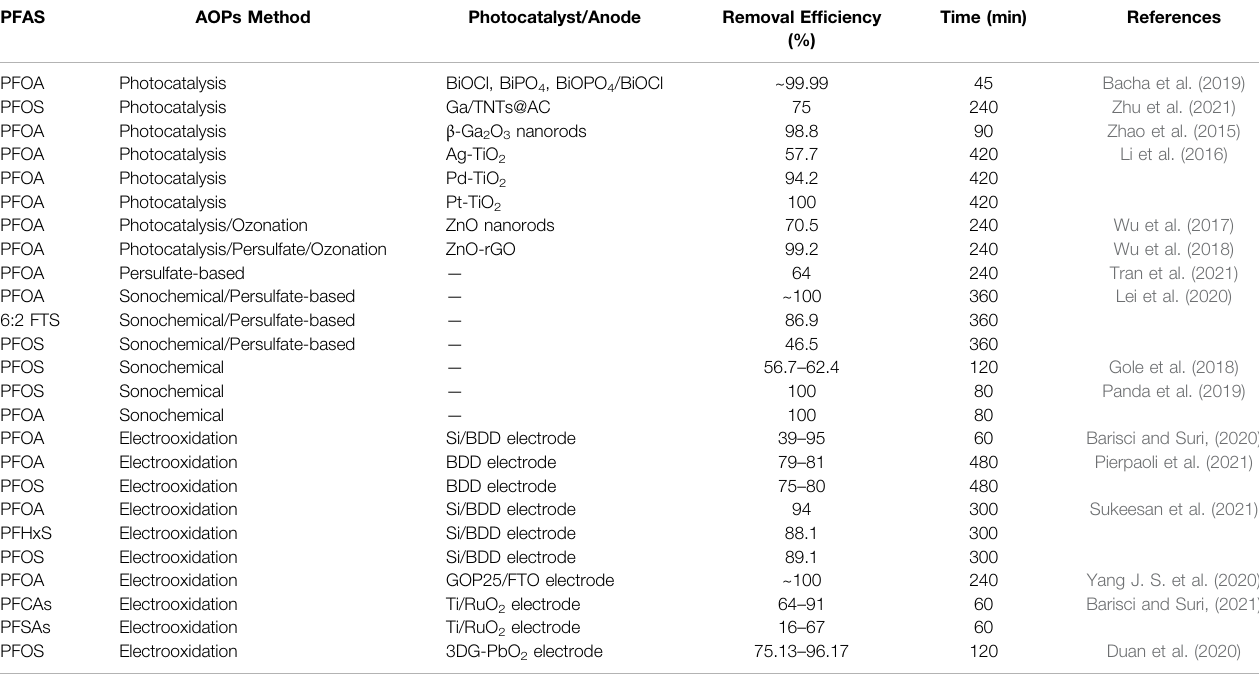
TABLE 2 | Degradation ef fi ciencies of PFAS by different AOPs methods.